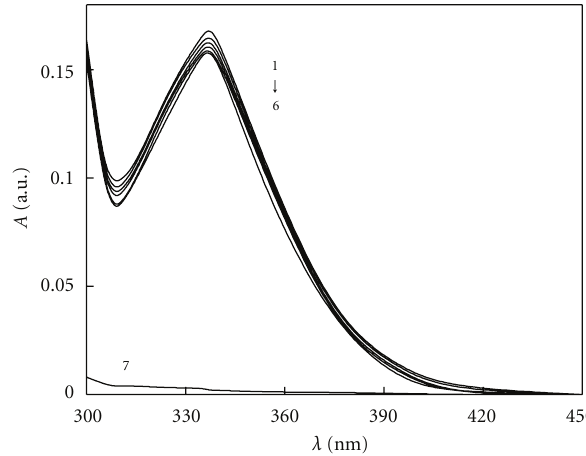
Figure 3: Absorption spectra of Avelox-BSA system From (1) to (6), C = 1.0 × 10 − 5 M, C = (0, 0.05, 0.1, 0.5, 0.8, 1.0) × 10 − 6 M, Avelox BSA (7): C BSA = 1.0 × 10 − 6